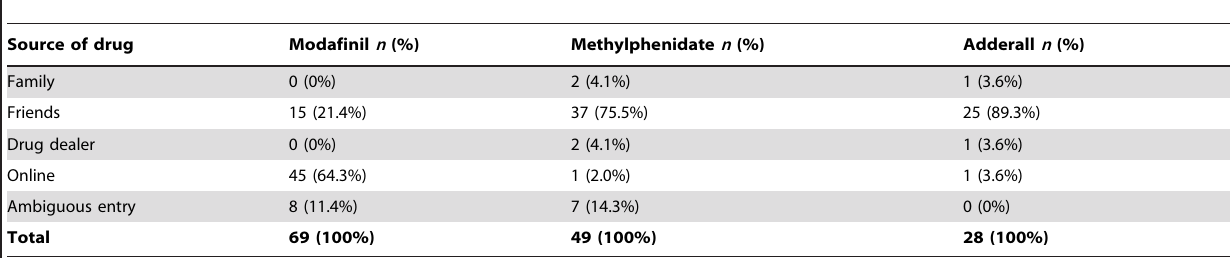
Table 8. Source of PCEs reported by users of these substances.